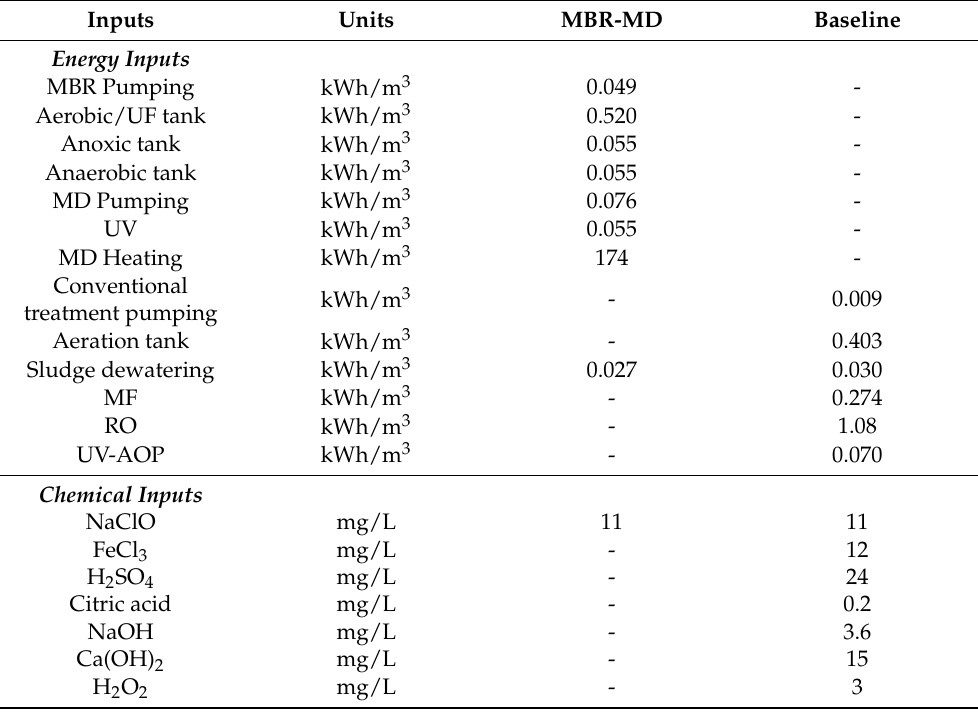
Table 3. The complete LCI for the MBR-MD and Baseline systems based on a functional unit of 1 m 3